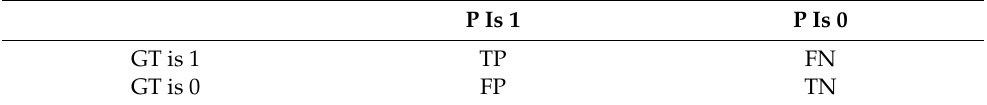
Table 1. Four types of road extraction results. GT is the ground truth, and P is the prediction, TP is a positive sample that is correctly judged, and FP is a positive sample that is incorrectly judged. TN is a negative sample that is correctly judged and FN is a negative judgement (false judgement).